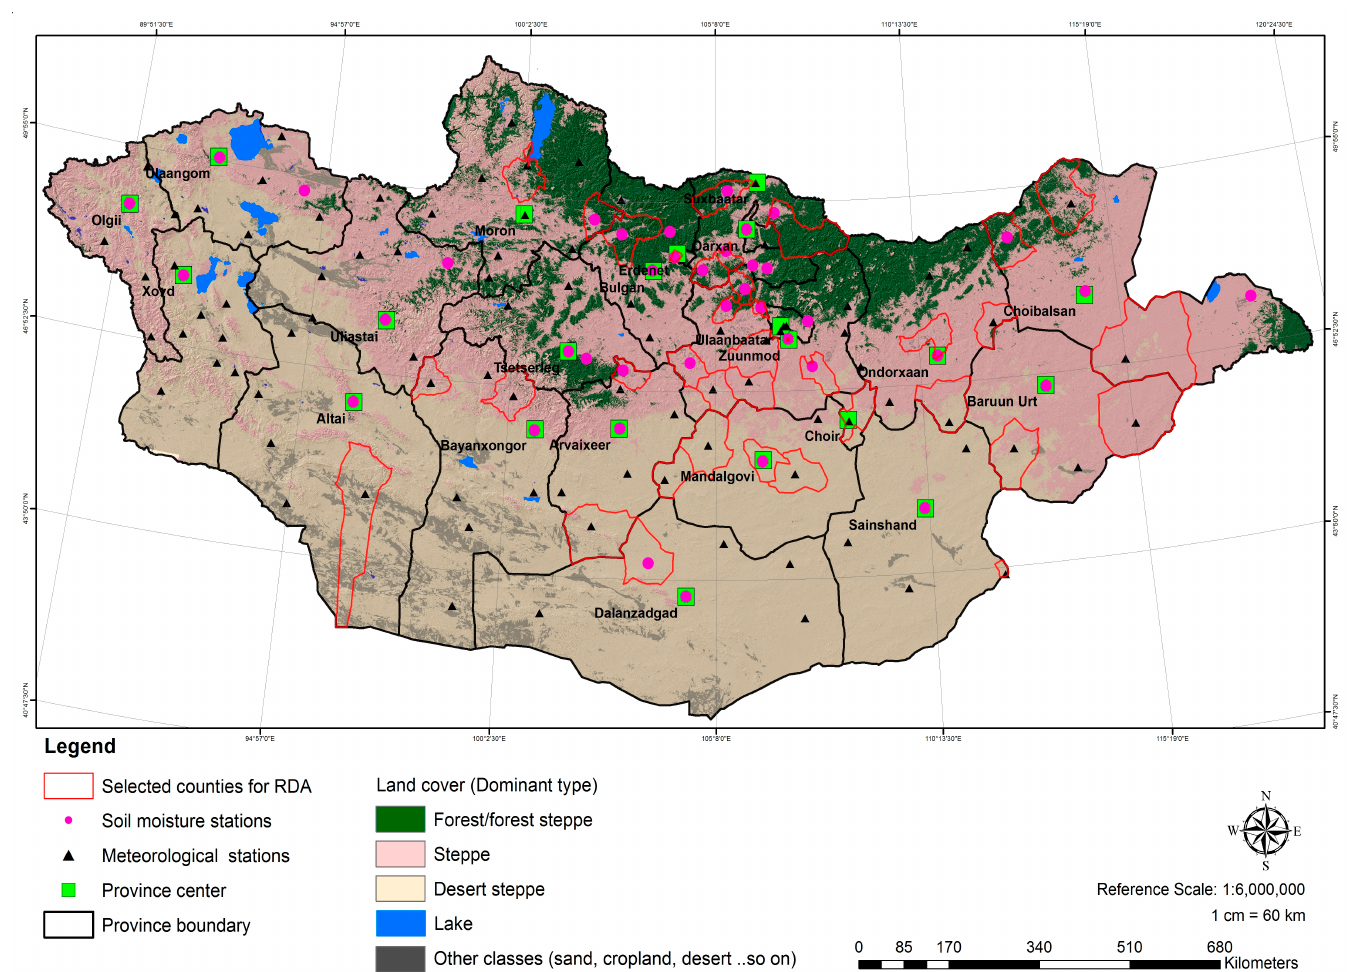
Figure 1. Study area and field stations distribution.